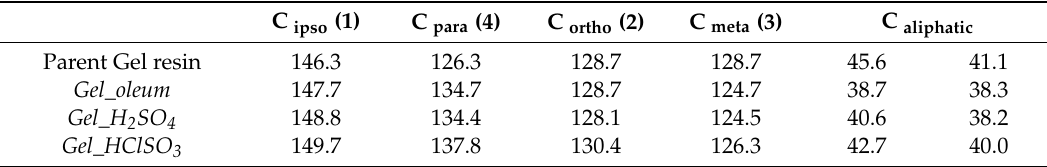
Table 4. Signal attribution of 1 H 13 C MAS spectra of the sulfonic samples ( δ , ppm).